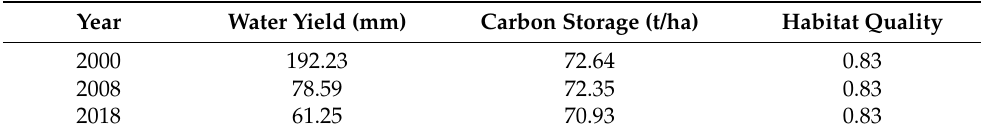
Figure 4. Spatial patterns of ecosystem services in the Danjiangkou reservoir area from 2000 to 2018. Table 3. Average value of annual changes in ecosystem services in the Danjiangkou reservoir area from 2000 to 2018.